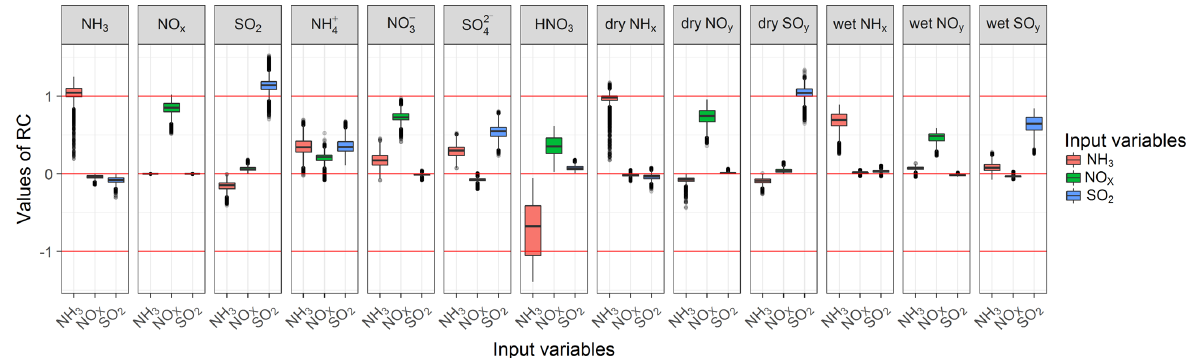
Figure 1. Box plots of the values of RCs across all UK land-based model grid squares. Boxes demarcate the median and lower/upper quartiles of the distributions; whiskers extend to 1.5 times the interquartile